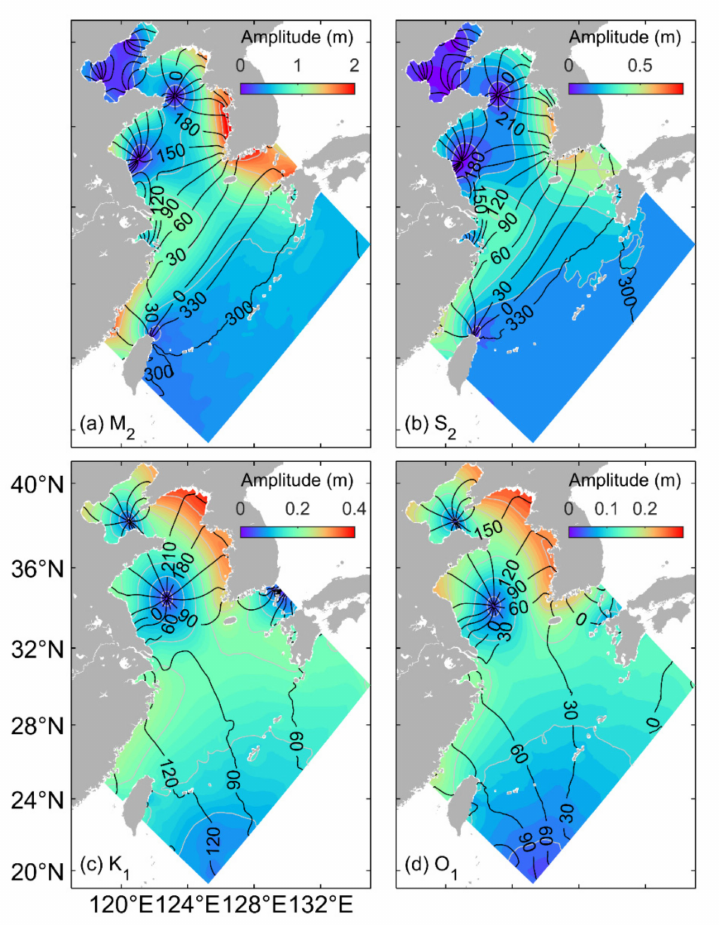
Figure 3. Co-amplitudes (image with grey contour lines) and co-phases (black contour lines) of four major tidal elevations of ( a ) M 2 , ( b ) S 2 , ( c ) K 1 and ( d ) O 1 over the China Sea and adjacent deep ocean waters of the northwestern Pacific Ocean computed from sea levels produced by the outer model. The tidal phases are in degrees relative to the